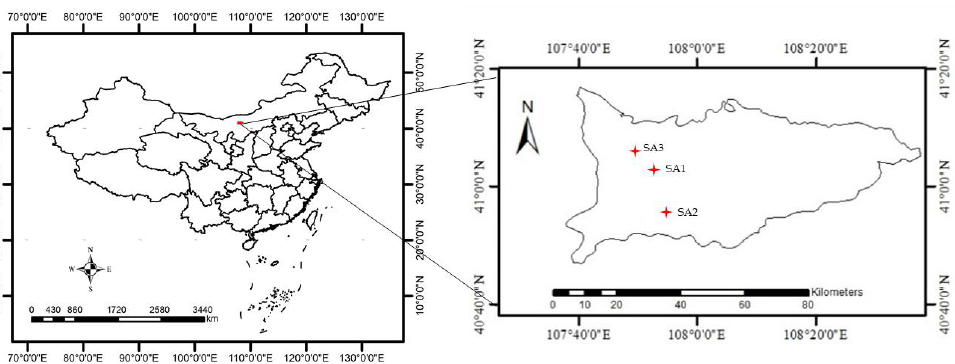
Figure 1 . Geographical location of the study areas. Figure 1. Geographical location of the study